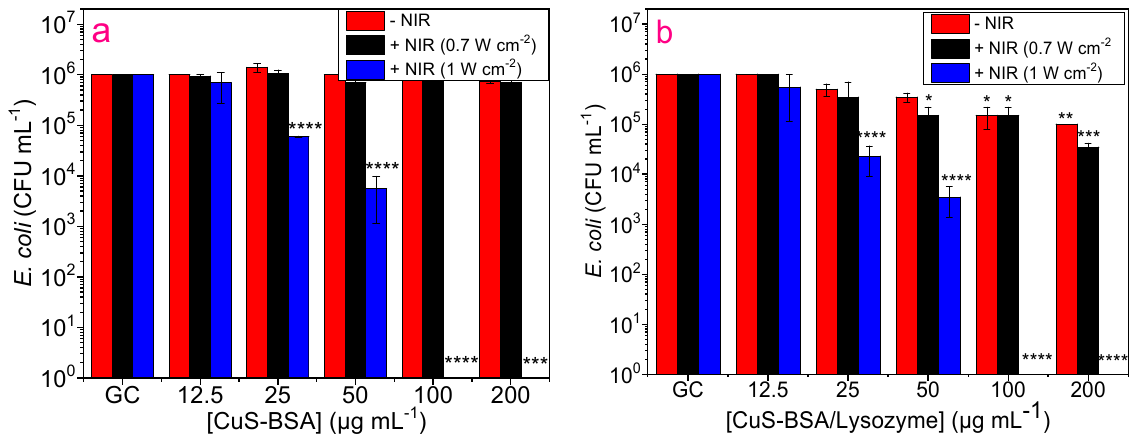
Figure 8. Antibacterial activity of ( a ) CuS-BSA and ( b ) CuS-BSA/lysozyme on E. coli using various concentrations with and without NIR irradiation (980 nm, 3 min). * p < 0.05, ** p < 0.01, *** p < 0.001, **** p < 0.0001.